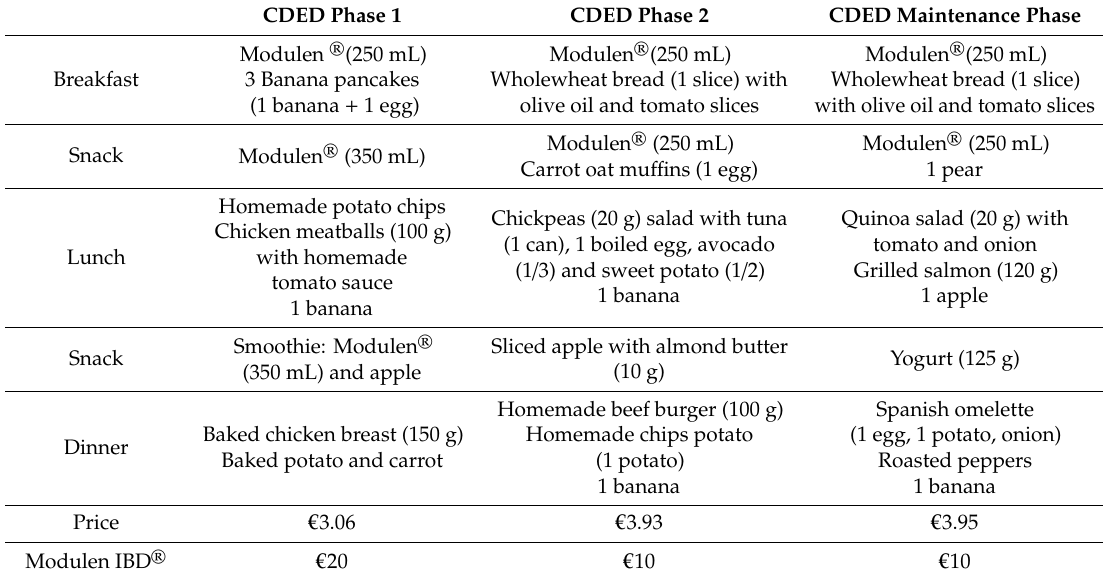
Table 6. Expenditure on food during the phases of CDED (2000 kcal /